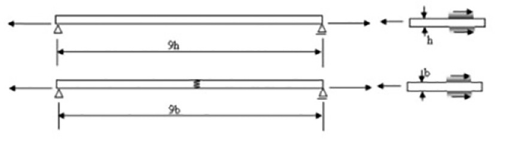
Figure 3: In tensile testing scheme for timing amendments 8